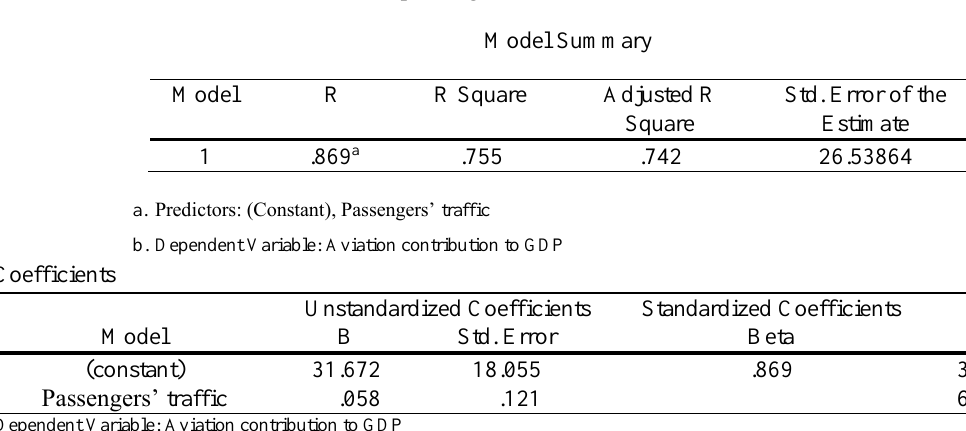
Table 3. Effect of passengers’ traffic on aviation contribution to